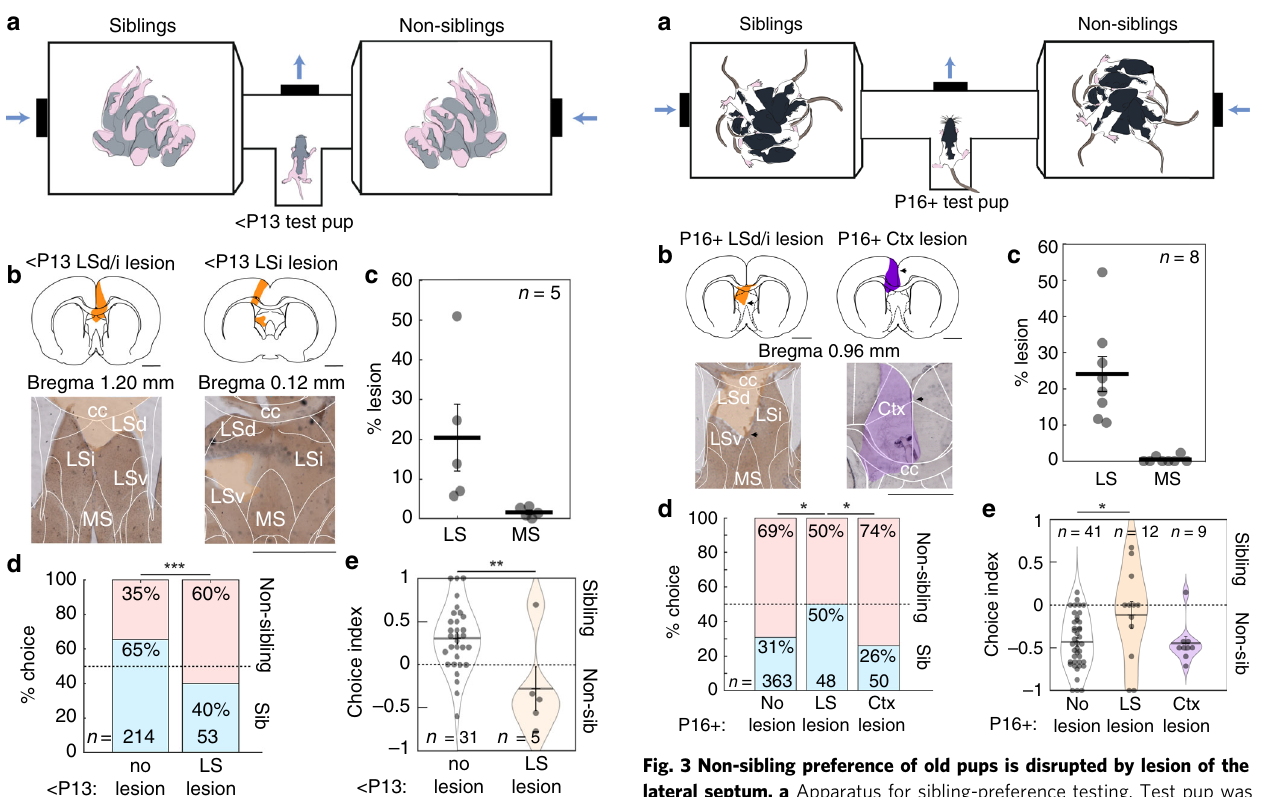
proportion of neurons responded to odors (75%, 33 neurons) compared with calls (20.5%, 9 neurons) and few neurons (4.5%, 2 neurons) responded to both odors and calls (Fig. 5g, bottom).